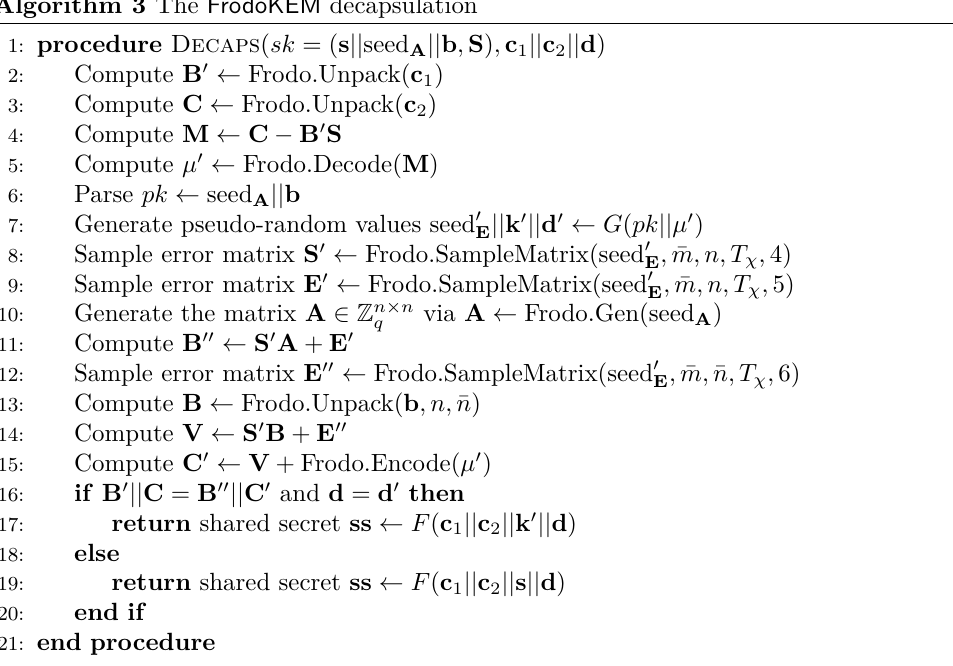
Algorithm 3 The FrodoKEM